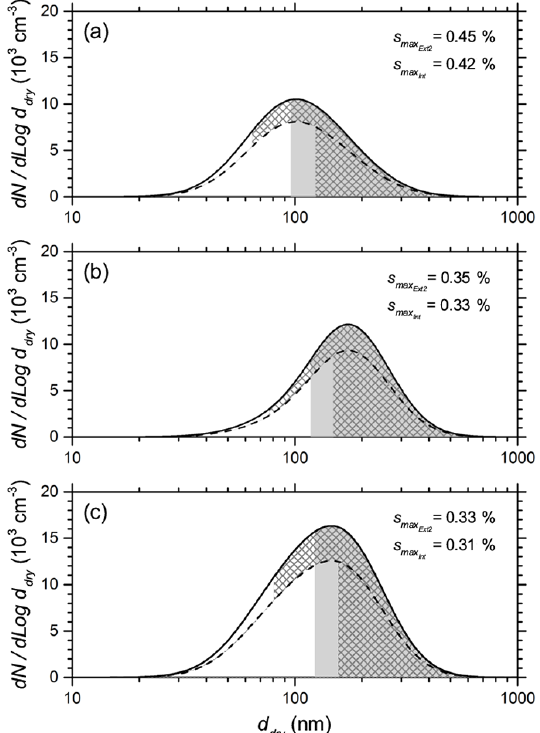
Figure 4. Schematic number size distribution of particles activated in Ext 2 (hatched area) and Int (grey area) mixing states, for an av- = 0 . 10, obtained for = 0 . 10 and W = 5ms − 1 , for (a) MP erage κ p 5 , 1 , (b) MP 1 , 5 and eff eff (c) HP 5 , 5 case studies. Total aerosol population (black, solid line), hygroscopic group κ p = 0 . 04 (black, dashed line) and maximum su- persaturation reached in the simulations for each mixing state are